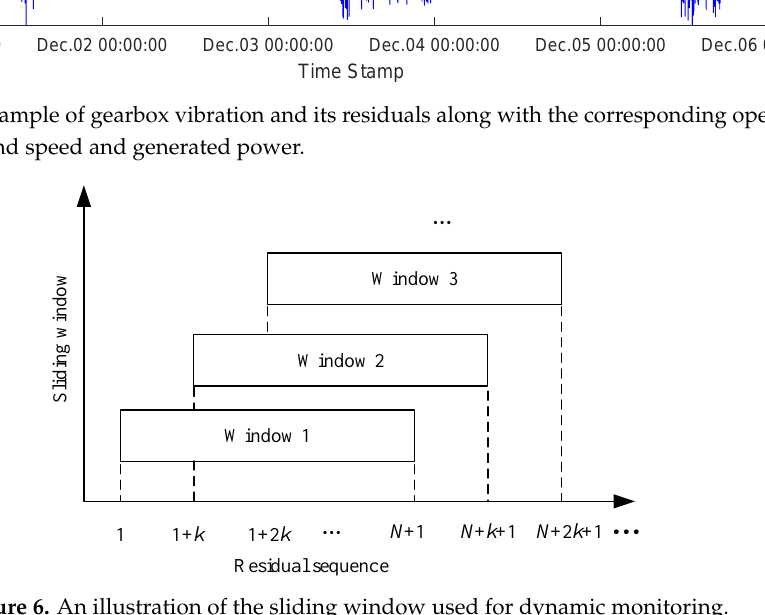
Figure 6. An illustration of the sliding window used for dynamic